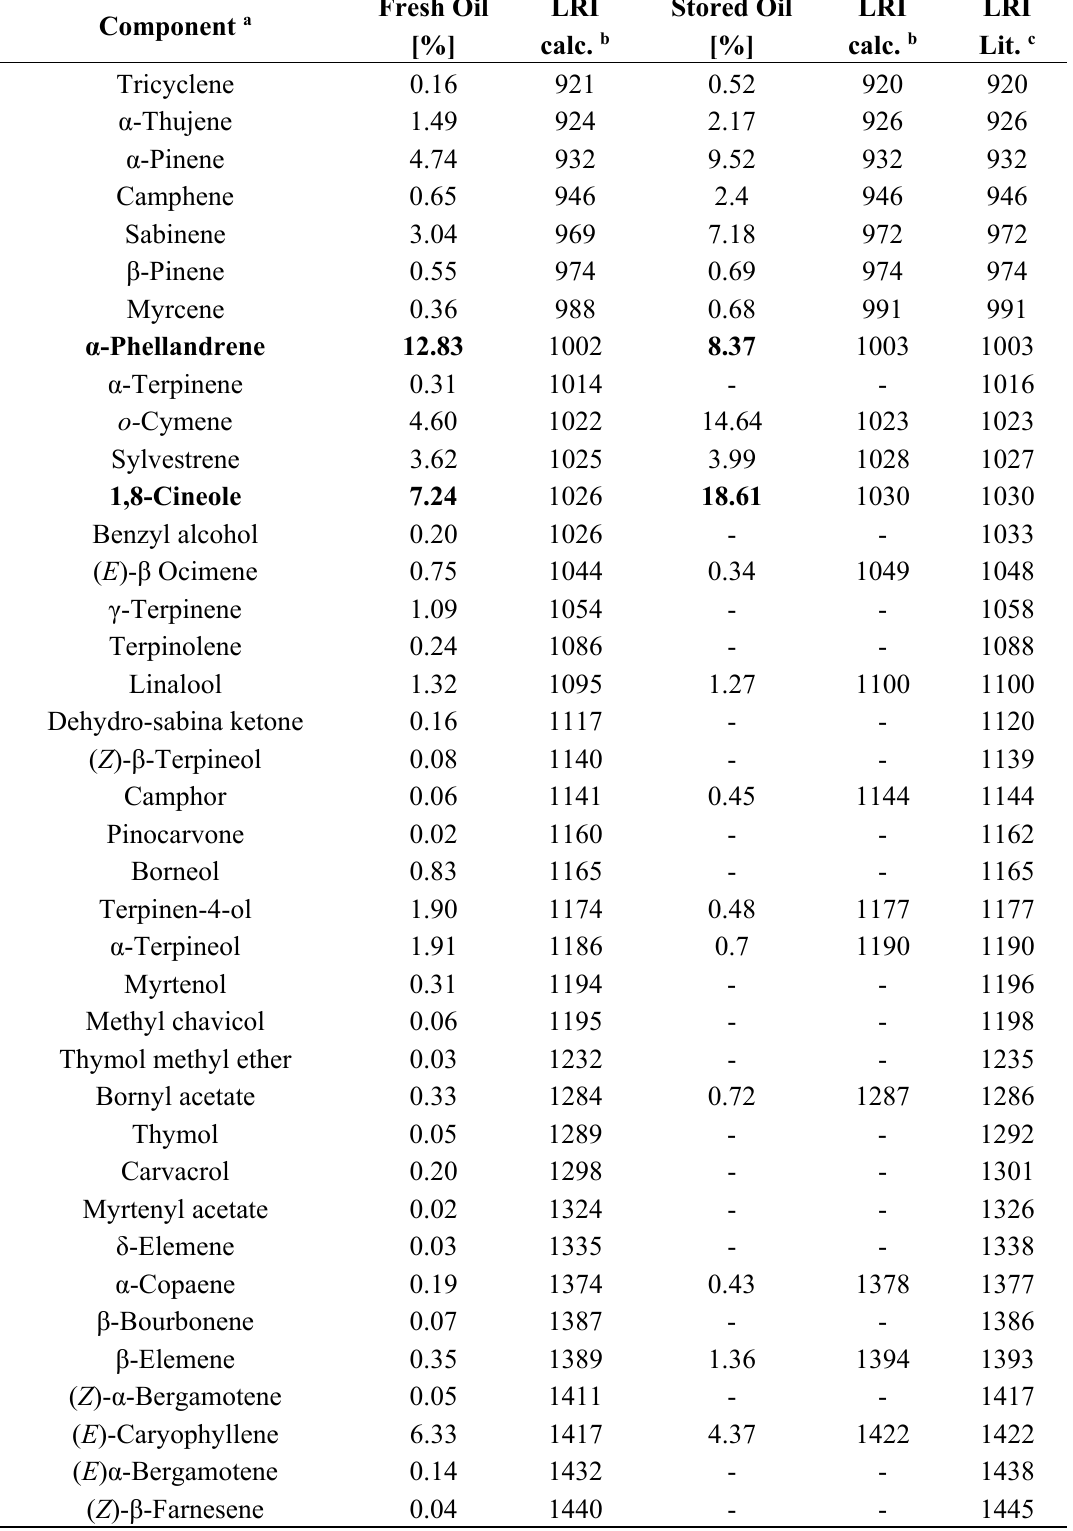
Table 1. Volatile compounds identified in fresh and stored samples of essential oil from Croton